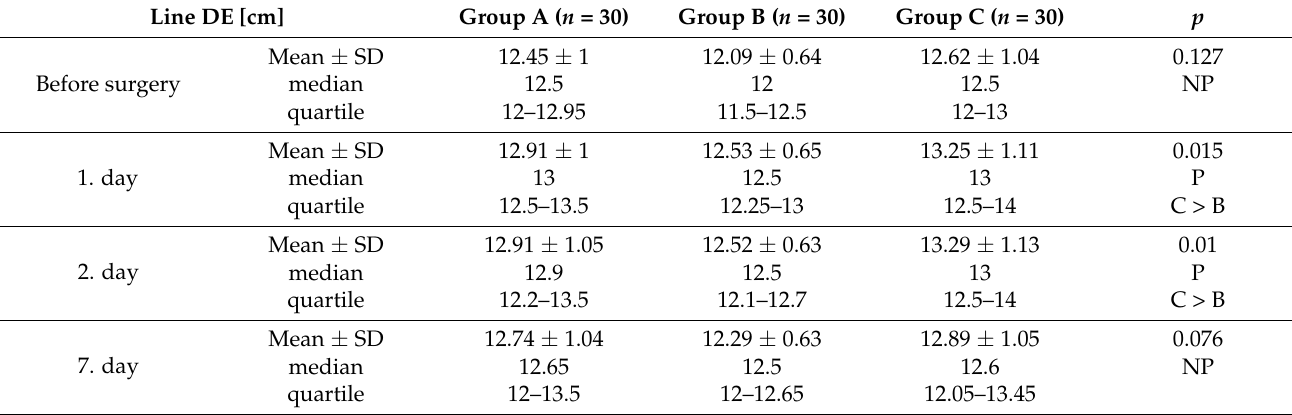
Table 8. Results of comparative analysis of DE line length before treatment and at day 1, 2, and 7 after treatment between groups A, B,